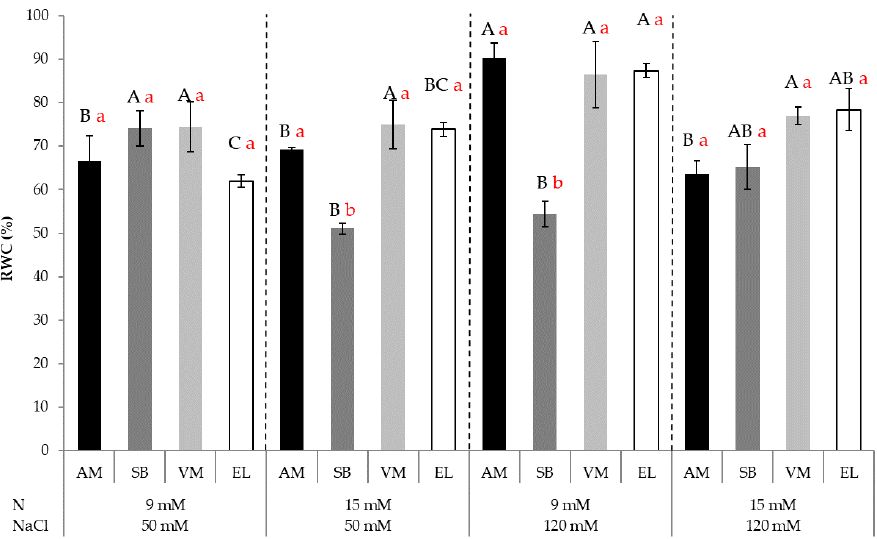
Figure 3. Relative water content (RWC) in Arthrocnemum macrostachyum (AM), Salicornia brachiata (SB), and Sarcocornia fruticosa ecotypes (EL and VM). LN under different combinations of N (9 and 15 mM) and NaCl (50 and 120 mM). Means plus standard errors ( ± SE) are shown. Different uppercase letters show significant differences between treatments of one ecotype (same color bars), and different lowercase red letters show significant differences between ecotypes within the same treatment (Tukey’s HSD, p ≤ 0.05, n = 3).